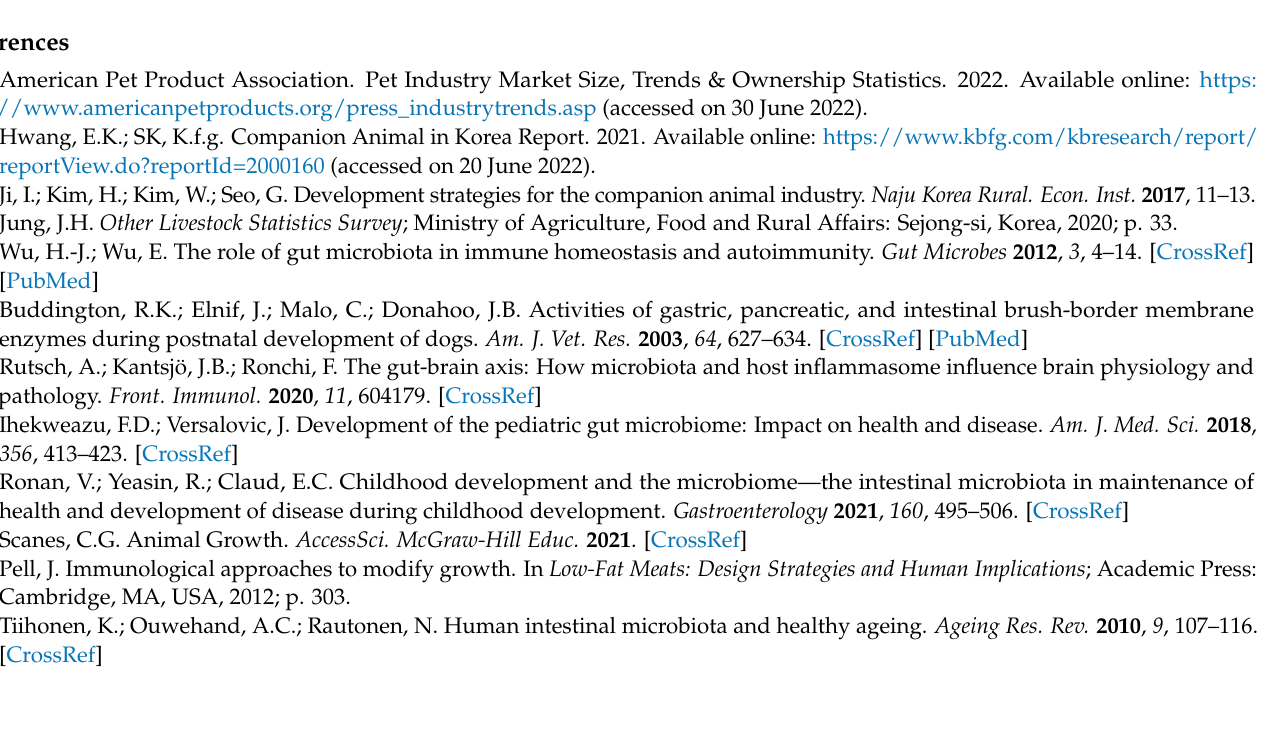
quality control; Table S2: Relative abundance of phylum and genus; Table S3: Significant correlation pairs; Table S4: COGs prediction results; Table S5: ALDEx2 results between the 4-month and 16-month